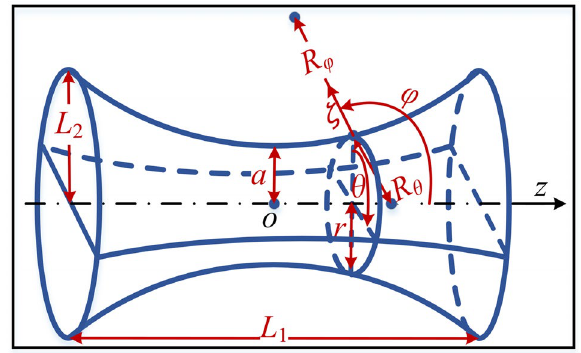
Figure 1. The geometry of hyperbolic flexible